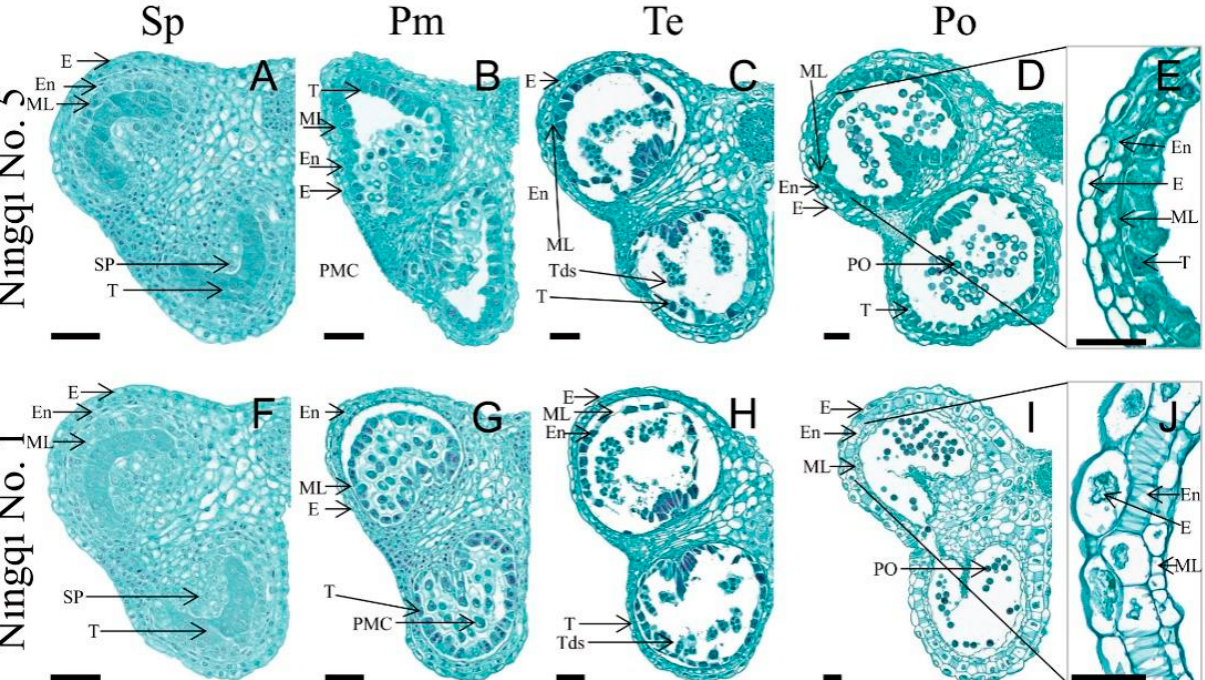
Figure 1. Paraffin sections of Ningqi No. 5 and Ningqi No. 1 pollen sacs at different development stages. ( A – E ) Pollen sac development of Ningqi No. 5; ( F – J ) pollen sac development of Ningqi No. 1; ( A , F ) pollen sacs of Sp stage; ( B , G ) pollen sacs at Pm stage; ( C , H ) pollen sacs at Te stage; ( D , I ) pollen sacs at Po stage; ( E , J ) anther wall layers at Po stage. E, epidermis; EN, endothecium; ML, middle layer; T, tapetum; Tds, tetrad; PMC, pollen mother cell; SP, sporogenous cell; Po, pollen grain. Scale bar = 50 μ m.